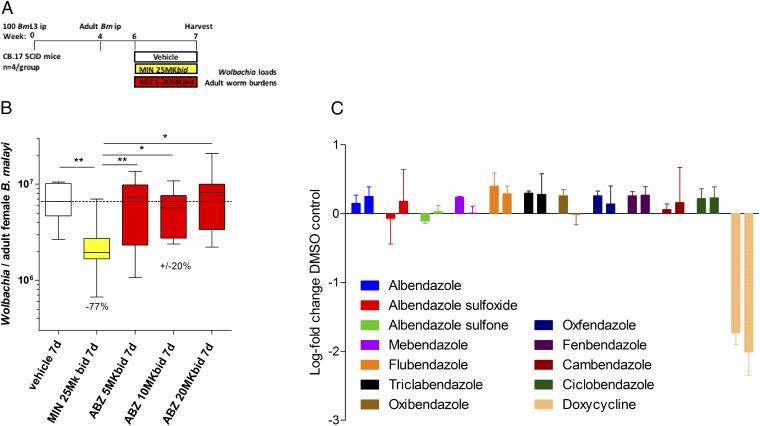
Schematic of drug treatment protocol (A). Wolbachia loads in B. malayi females immediately following 7-d exposure with MIN or ABZ at indicated doses (B). Box and whiskers are median, minimum/maximum Wolbachia surface protein (wsp) gene copy number, derived from a pool of 10 individual worms, sourced from groups of four SCID mice. Significant differences are assessed by Kruskal–Wallis one-way ANOVA (female worm Wolbachia depletions Kruskal–Wallis statistic: 21.79, P = 0.0002) with Dunn’s multiple tests: *P < 0.05, **P < 0.01. (C) Change in Wolbachia load compared with vehicle control following 7-d exposure to listed compounds (all 5 μM) within an A. albopictus cell line stably infected with wAlbB (C6/36 wAlbB). Bars are mean log-fold change (+SEM) from triplicate wells from two individual experiments.